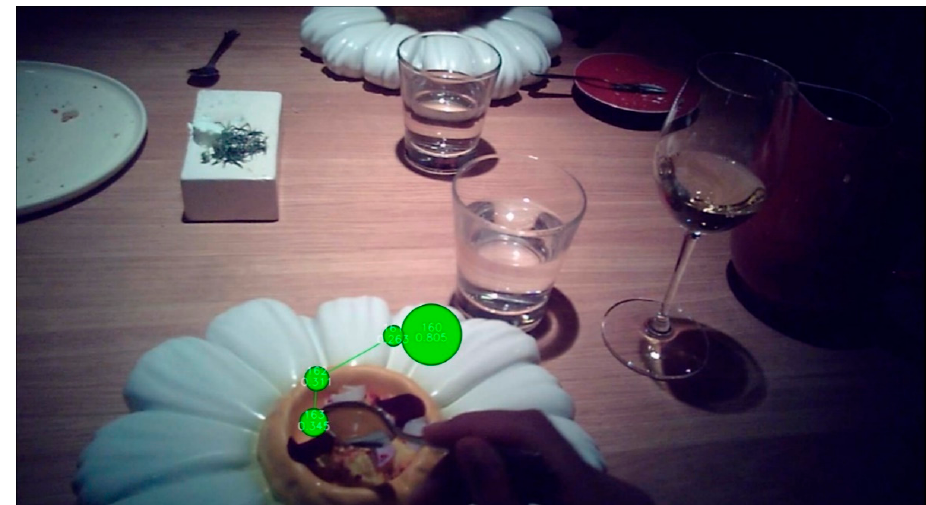
Figure 2. Neuromarketing empirical study. Source: Original work from the authors.